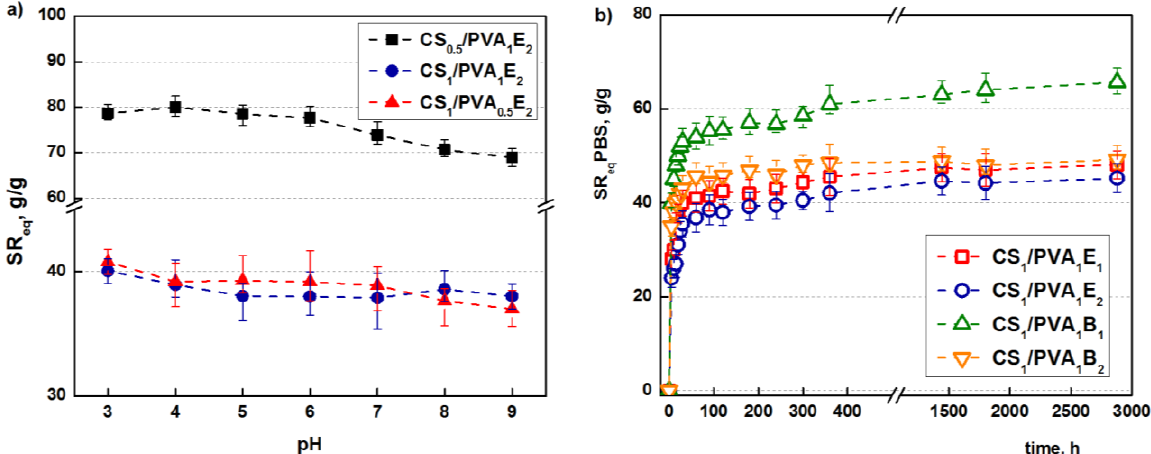
Figure 4. Influence of the pH of the swelling medium on the SR eq ( t T = 24 h) ( a ). Swelling kinetics in simulated physiological conditions, PBS at pH = 6.8 ( t T = 24 h) ( b ).